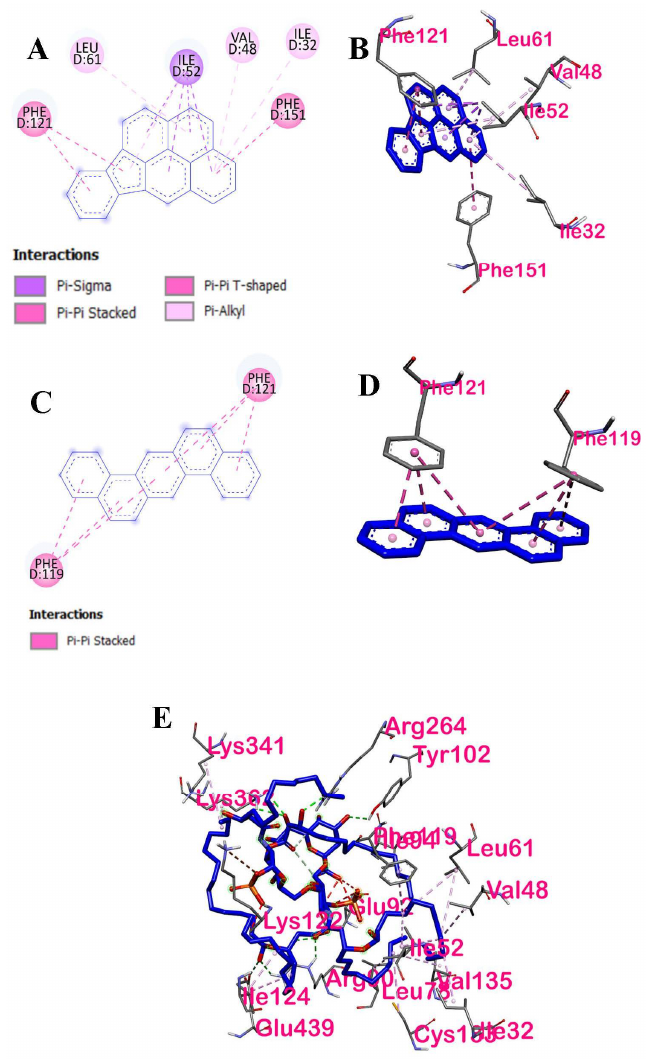
Figure 8. The two- and three-dimensional interactions of LPS, DahA and IP with TLR4: ( A ) 2D interaction of Indeo(1,2,3-cd)pyrene and TLR4; ( B ) 3D interaction of Indeo(1,2,3-cd)pyrene and TLR4; ( C ) 2D interaction of Dibenz(a,h)anthracene and TLR4; ( D ) 3D interaction of Dibenz(a,h)anthracene and TLR4; and ( E ) 3D interaction of LPS and TLR4.